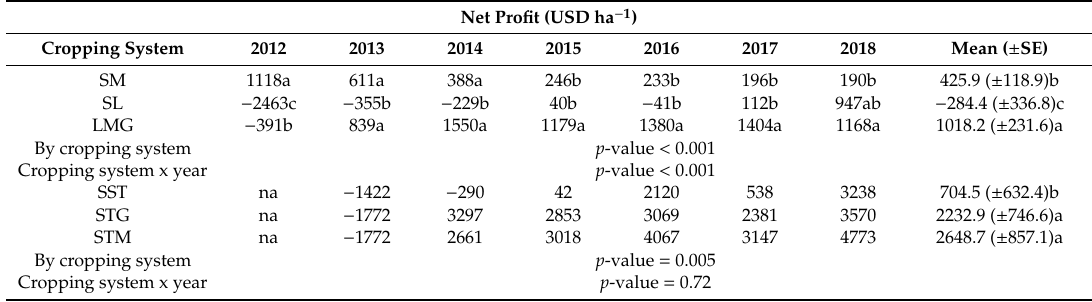
Table 3. Net profit from the agroforestry systems and the corresponding sole crop /